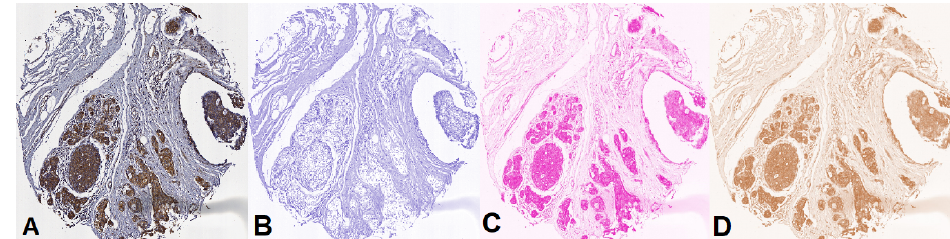
Figure 10. Colour deconvolution in histopathological images: ( A ) original TMA tissue core image; and ( B – D ) color deconvolution results separating the contribution of hematoxylin ( B ), eosin ( C ) and DAB ( D ) to the original image. Magnification 20 ×